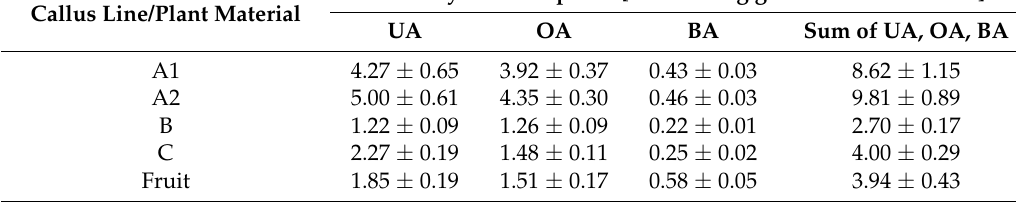
Table 3. The content (mg g − 1 d.w .) of selected pentacyclic triterpenes in four lines of Chaenomeles japonica callus.